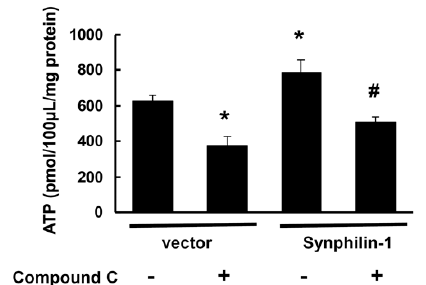
Figure 6. Compound C reduced synphilin-1-induced cellular ATP increase. HEK293 cells were transfected with myc-synphilin-1 and vector and treated with compound C (10 µ M) or vehicle for 48 h. Cells lysates were subjected to ATP assays. * p < 0.05 by ANOVA followed by Tukey’s post-hoc test, vs. vector control cells with vehicle treatment; # p < 0.05 by ANOVA, vs. cells expressing synphilin-1 with vehicle treatment.